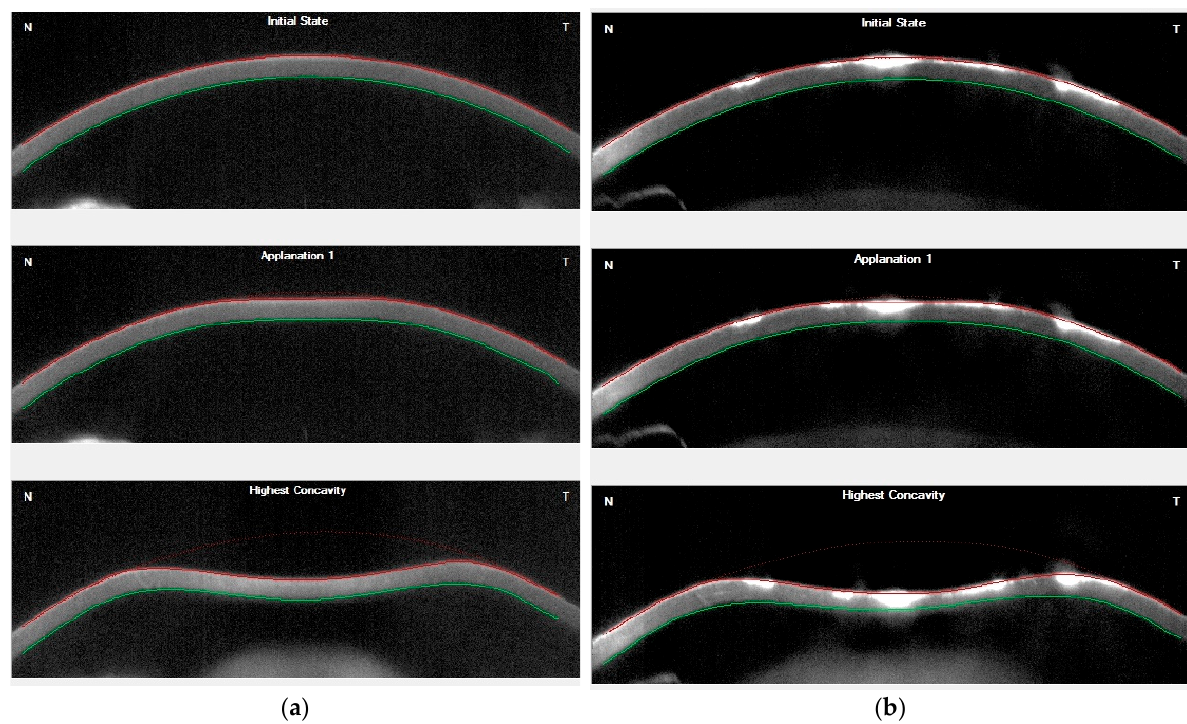
Figure 2. Corvis tomograms in ( a ) a normal subject; ( b ) a subject with granular corneal dystrophy (GCD).